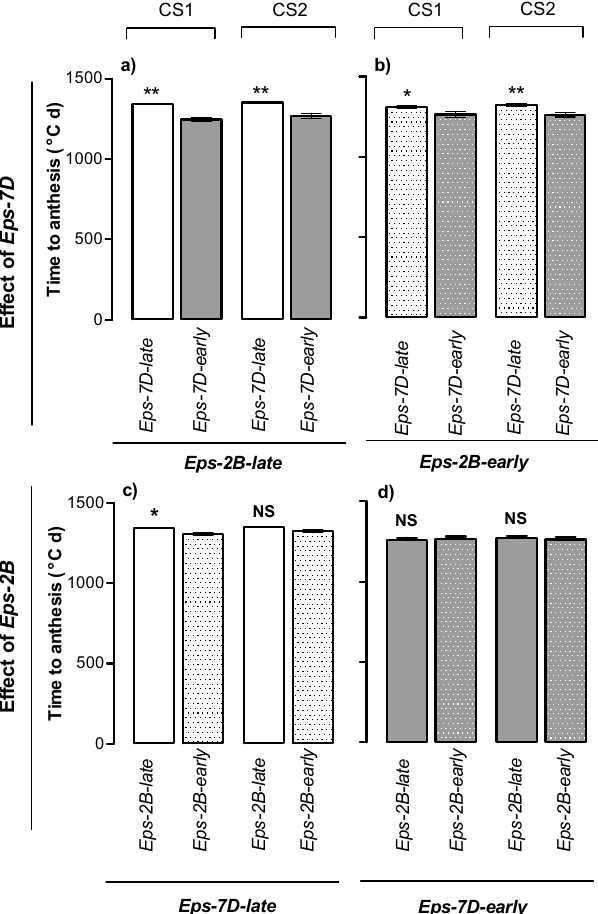
Figure 1. Duration of the crop cycle from sowing to anthesis for the lines carrying (1) the Eps-7D-late or early allele (upper panels) on the contrasting background of Eps-2B ( Eps-2B-late and - early , upper panel left and right, respectively); or (2) the Eps-2B-late or early allele (bottom panels) on the contrasting background of Eps-7D ( Eps-7D-late and - early , bottom panel left and right, respectively). Data are shown for each of the two cropping seasons (CS1 and CS2 within each panel). Significance level shown for the differences between alleles within each season: *p < 0.05; **p < 0.01; NS